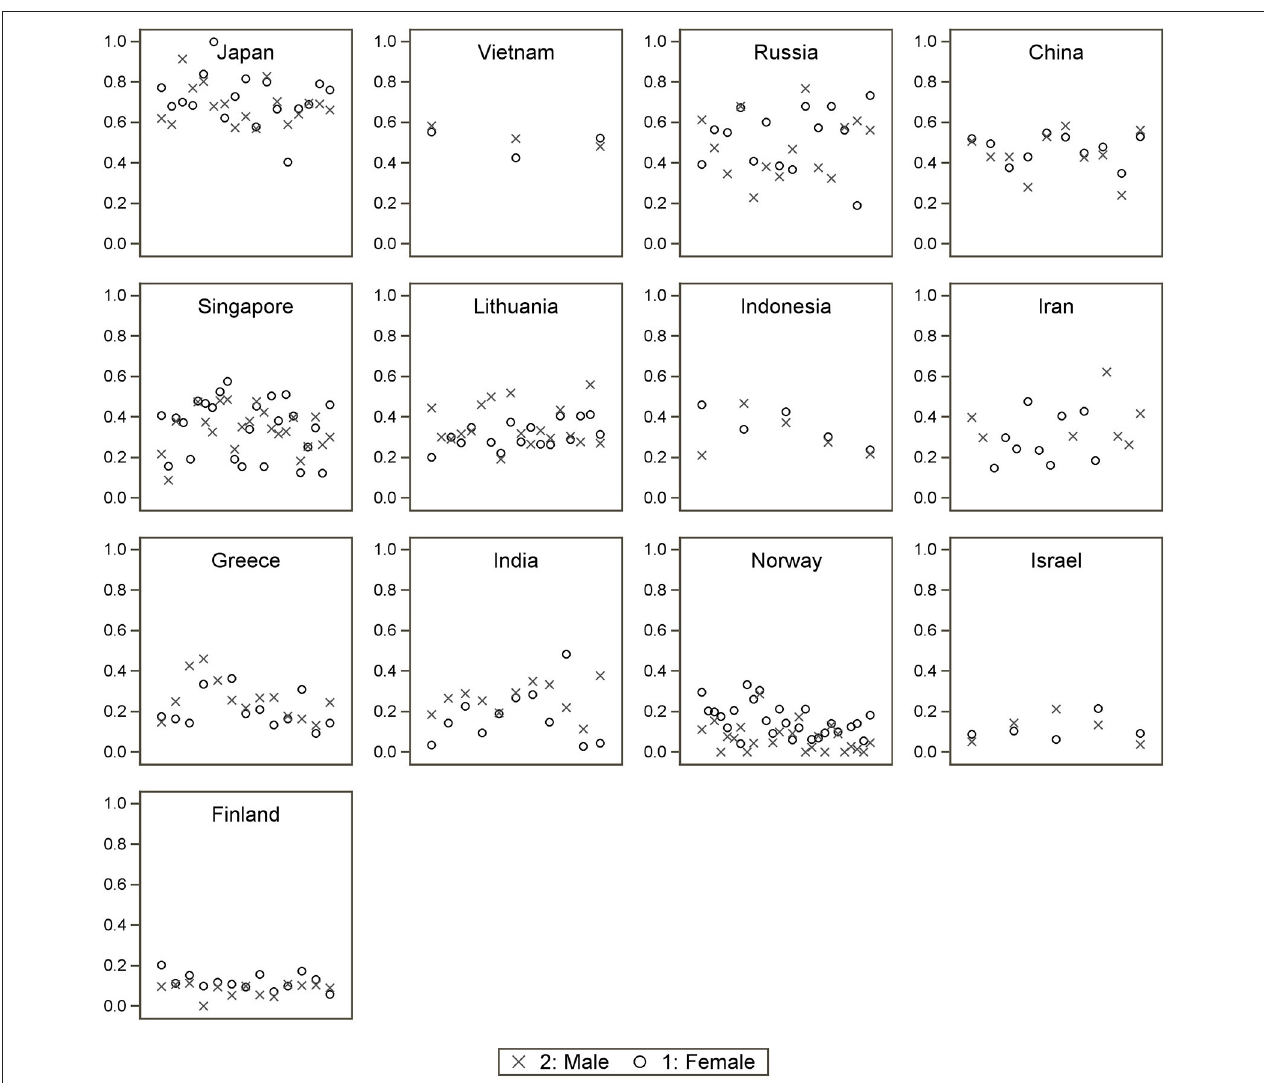
FIGURE 1 | Predicted probabilities of feeling unsafe at school by school and country, adjusted for age. The X axis shows schools in random